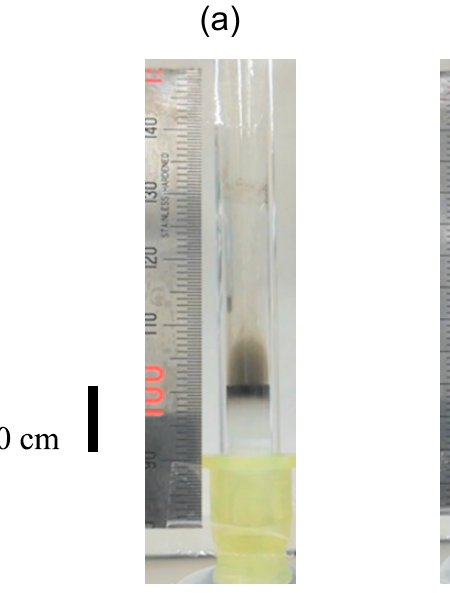
Figure 3. Picture of the rising elastic gel layer in the column. ( a ) Before permeation; ( b ) during permeation; and ( c ) after releasing the applied pressure.